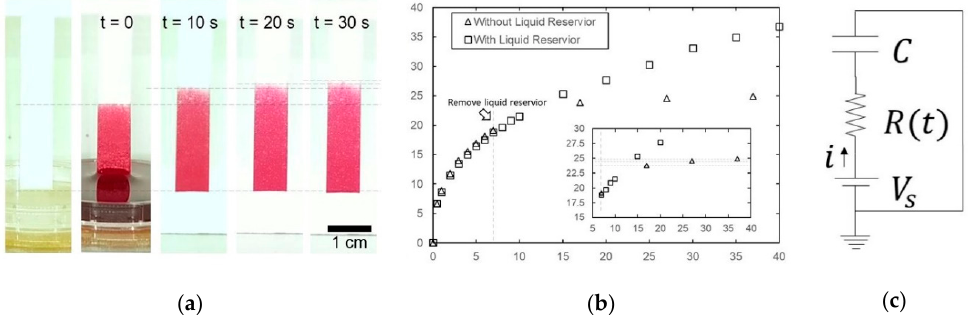
Figure 2. The ability to store liquid in paper matrix was observed ( a ) the sequential observed photos depicted the progress of liquid front after removing the liquid reservoir ( b ) the comparison of experimental data between with liquid reservoir and without liquid reservoir. ( c ) schematic diagram of an equivalent circuit for wicking in a paper strip with liquid reservoir.